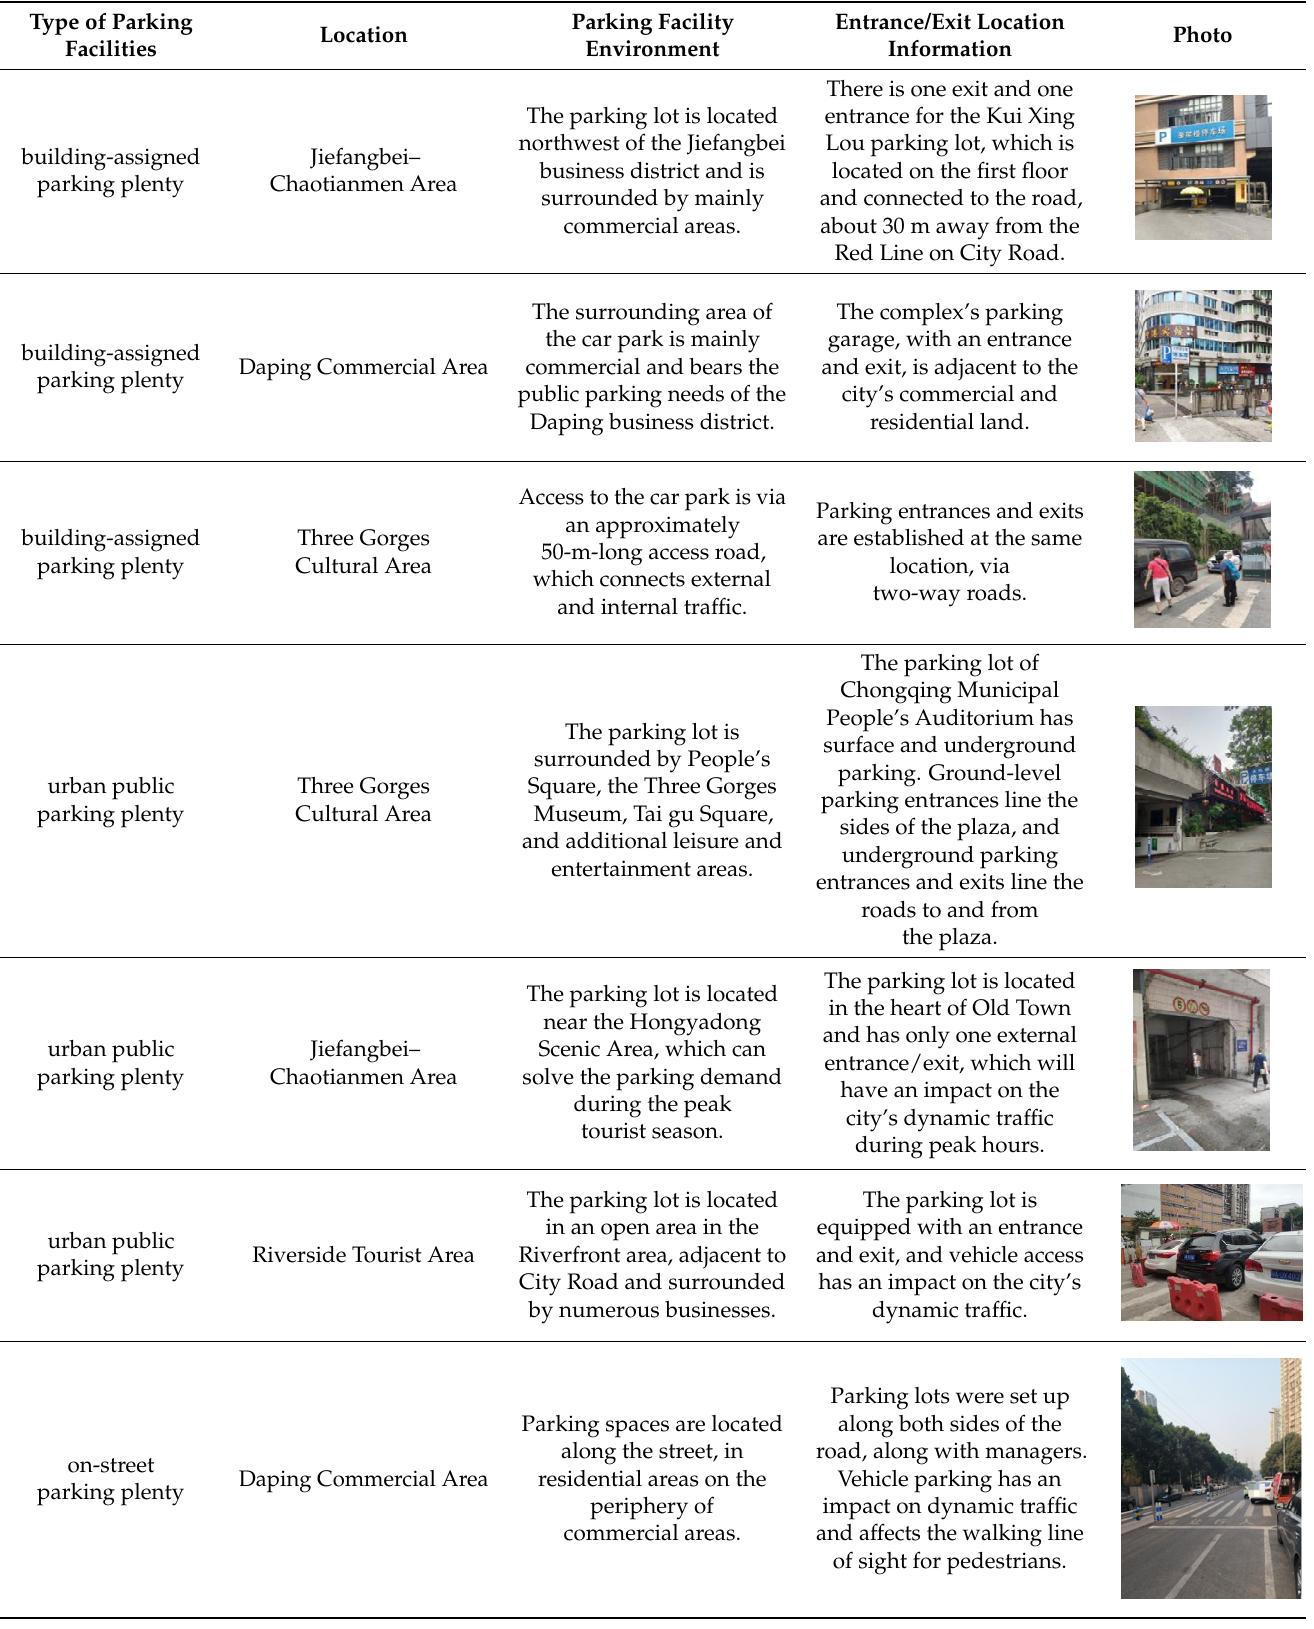
Table 3. Information on 9 typical parking facilities.